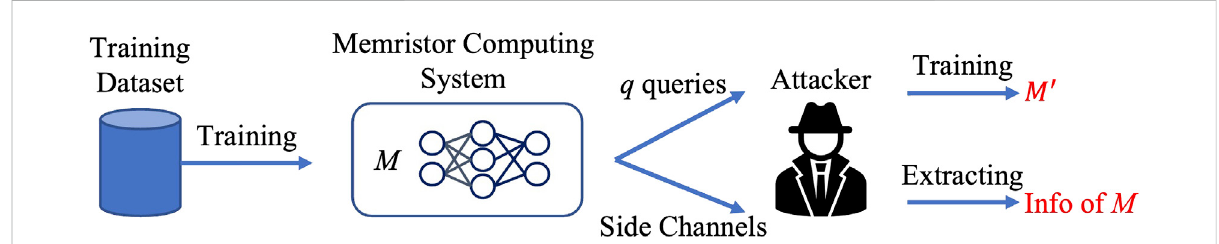
FIGURE 4 BB threat model: The attacker cannot access the training dataset but can query the memristor computing system loaded with the well-trained NN M in order to train a similar NN M ′ ; the attacker can also use side-channel techniques to extract M ’ s con fi dential information such as its NN